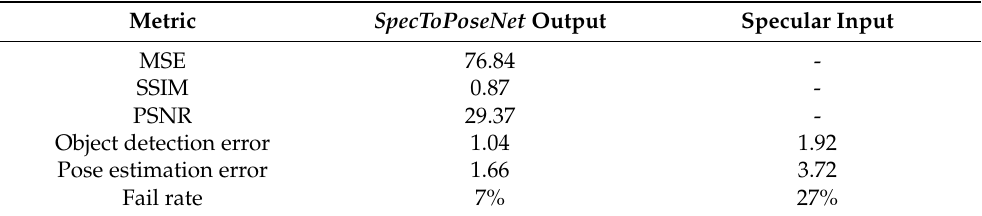
Table 3. Quantitative metric comparison for U-Net for basic SpecToPoseNet output and final SpecTo- PoseNet output.